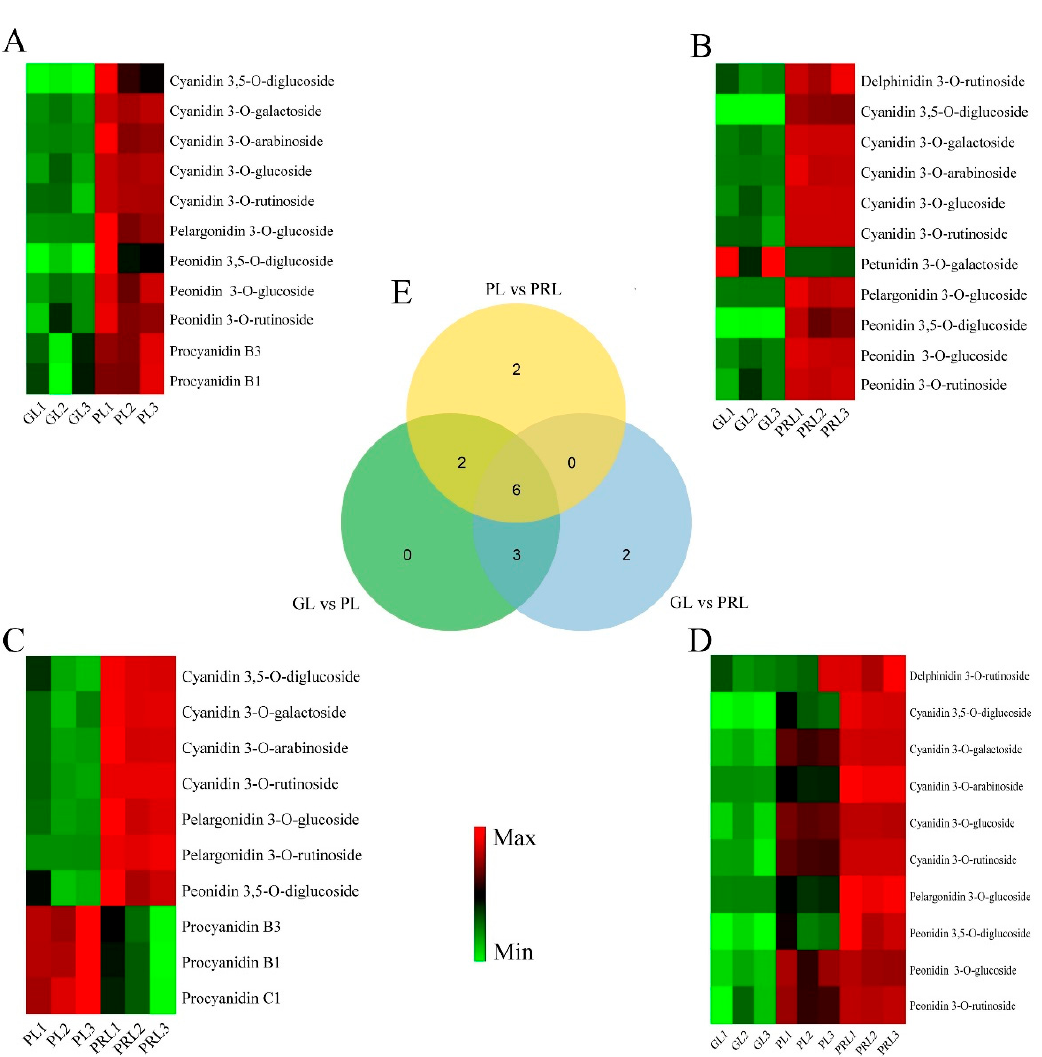
Figure 4. Heatmaps of differentially accumulated metabolites (DAMs) in GL vs. PL ( A ), GL vs. PRL ( B ), PL vs. PRL ( C ) and GL vs. PL–PRL. ( D , E ) Venn diagram of DAMs in P. virginiana . GL, green leaves; PL, purple leaves; PRL, purples-red leaves. The color scale from Min (green) to Max (red) refer to the metabolite contents from low to high. Identification of differentially accumulated metabolites (DAMs) between four comparison groups was performed by variable importance in projection (VIP) values (VIP ≥ 1) and fold change ≥ 2 or ≤ 0.5. Venn diagram representing overlap between DAMs identified in P. virginiana at GL vs. PL, GL vs. PRL and PL vs. PRL.